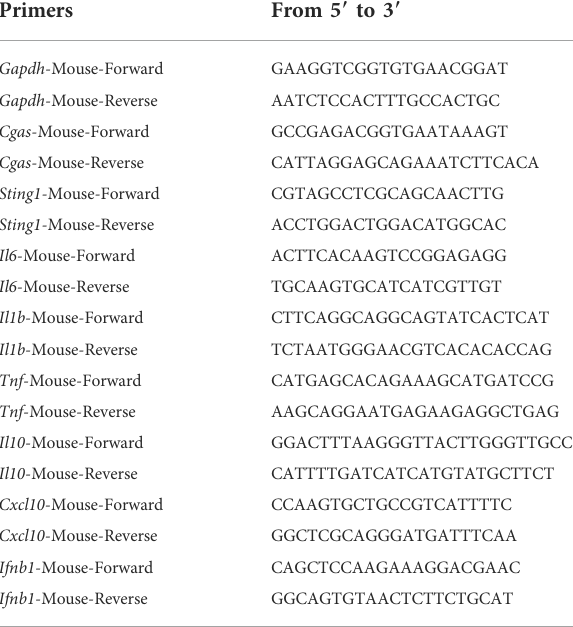
TABLE 1 Q-RT-PCR primer sequences used in this